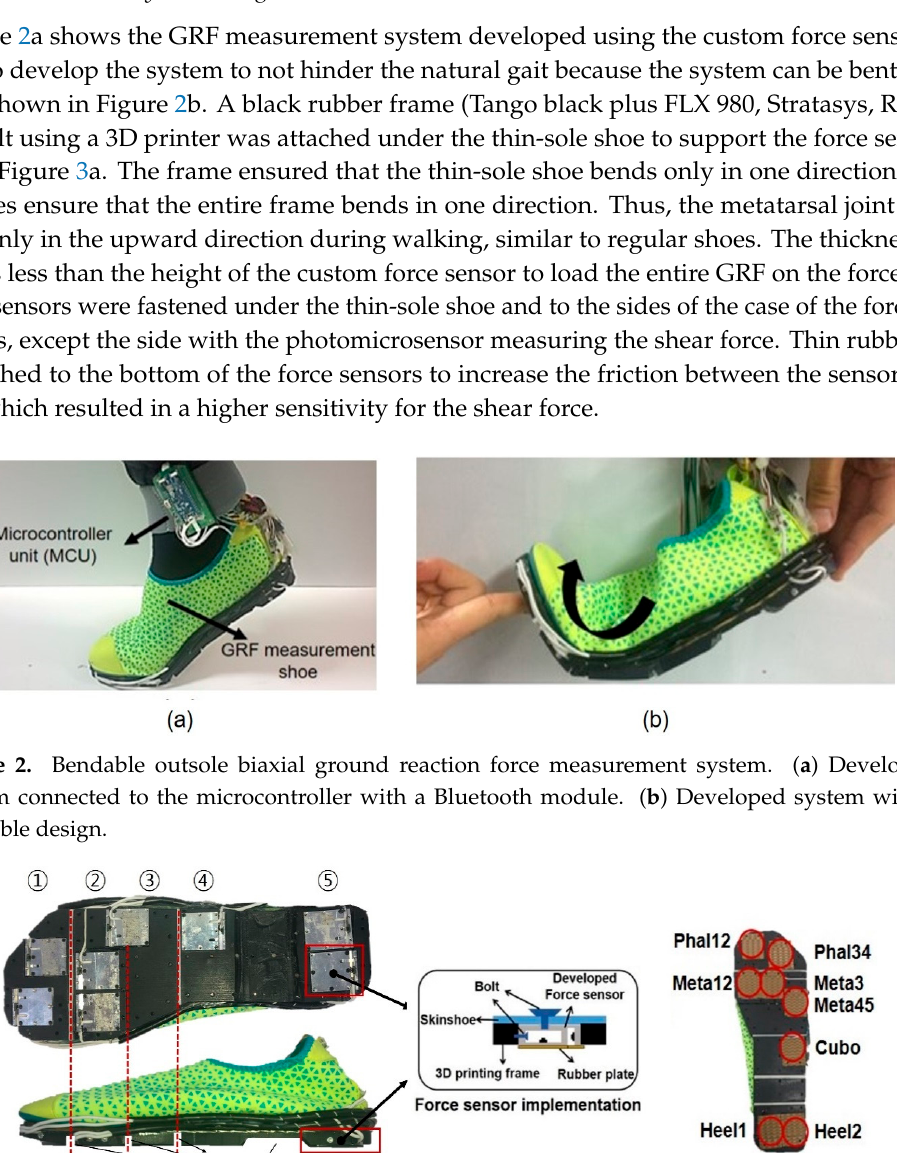
Figure 3. Design of the developed GRF measurement system. ( a ) Installation of the 3D printed rubber